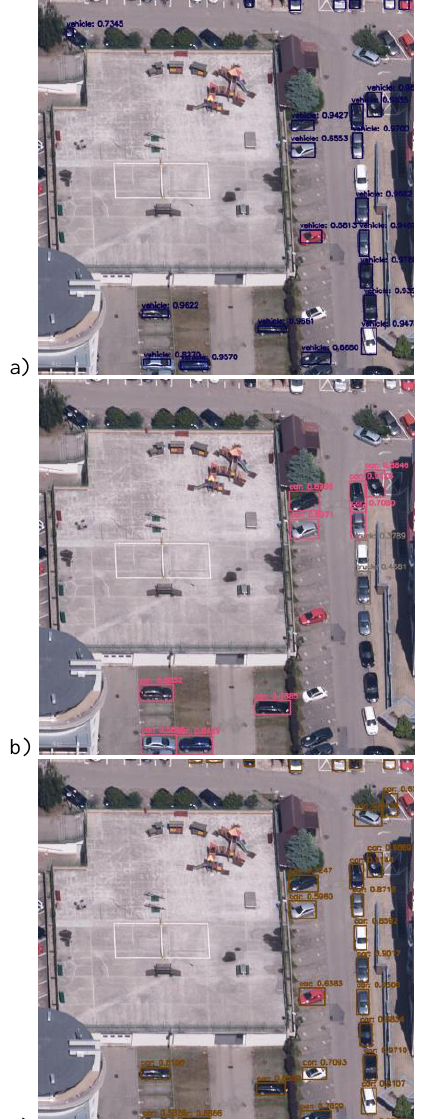
Figure 6. Detection results by YOLO network trained on three different datasets: a) DIOR, b) MSCOCO, c) a custom set consisting of detection results (annotations) on oblique images from the previous two steps (test area from Elbląg).